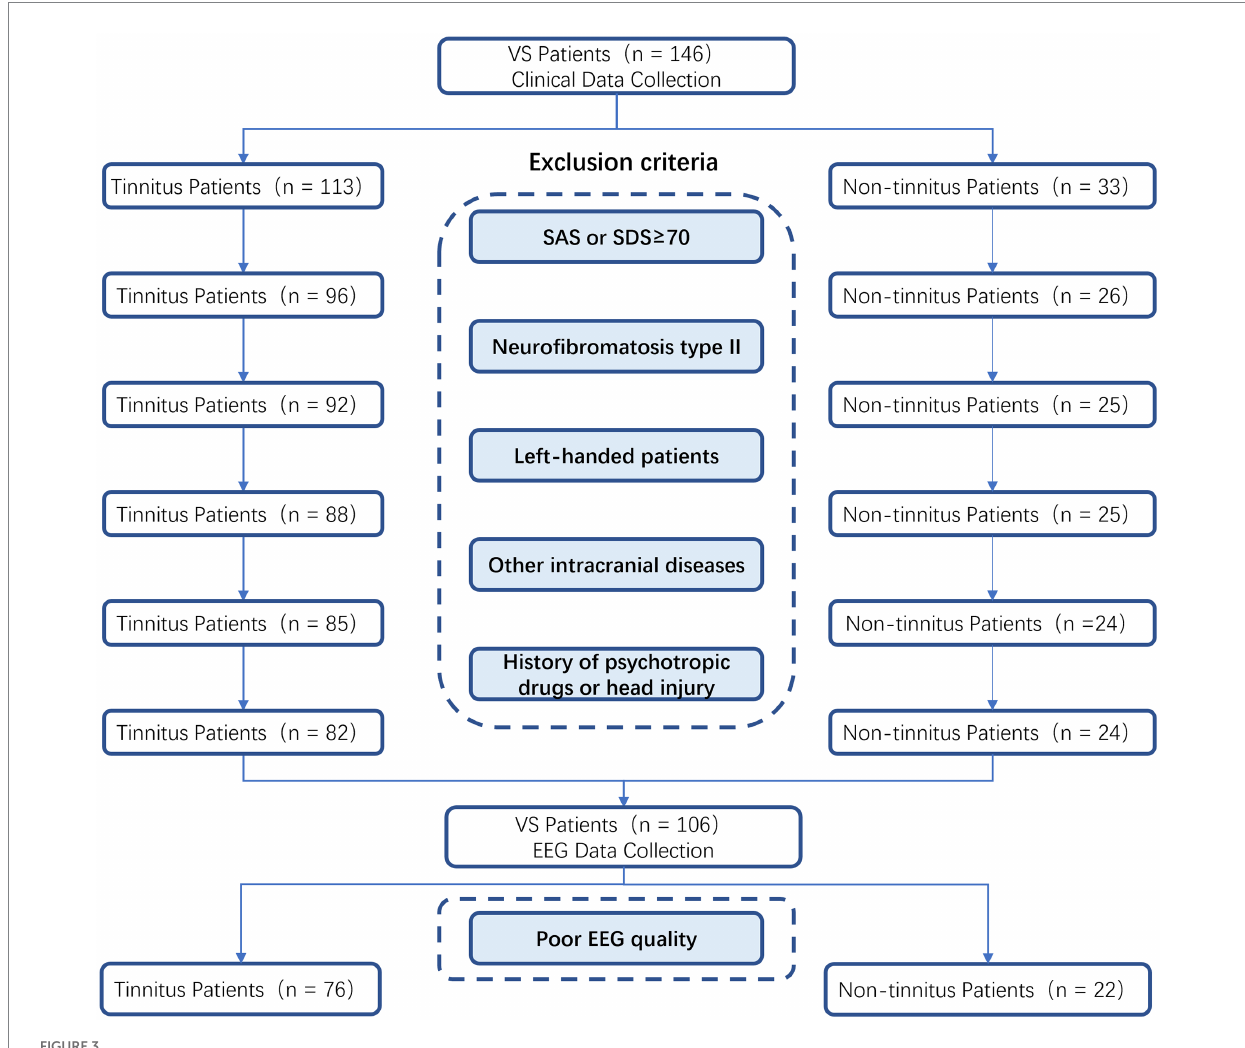
FIGURE 3 Flowchart for screening clinical and EEG